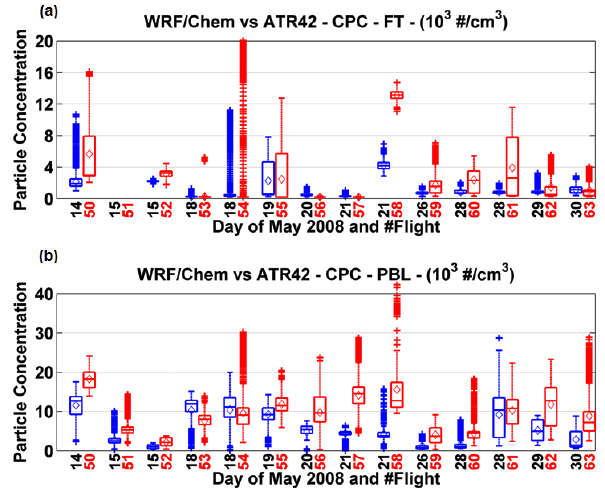
Figure 9. Same as Fig. 6 but for observed and simulated conden- sation nuclei (CN) concentrations. The blue colour represents the observations while the model is displayed in red